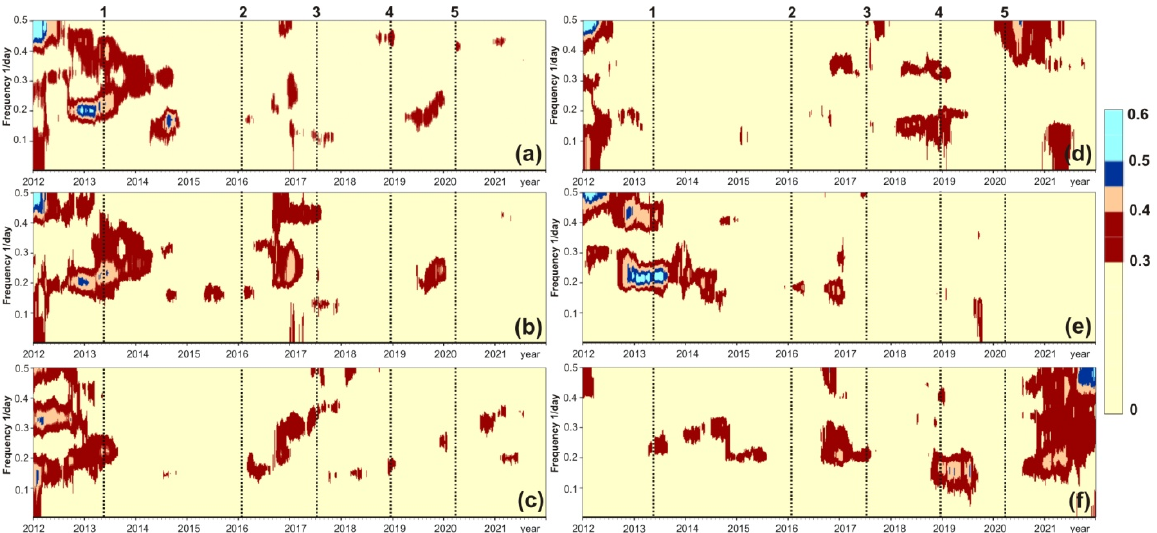
Figure 5. Time-frequency diagrams of the spectral measure of coherence of 4-dimensional time series of seismic noise parameters ν ( τ , ω ) in comparison with earthquakes (Table 3) according to data from ( a ) the entire network of stations, ( b ) non-volcanic, and ( c ) continental stations, as well as for the ( d ) northern, ( e ) central, and ( f ) southern groups of stations, 2011–2021. Synchronization effects of seismic noise parameters are distinguished by the values ν ( τ , ω ) ≥ 0.3.